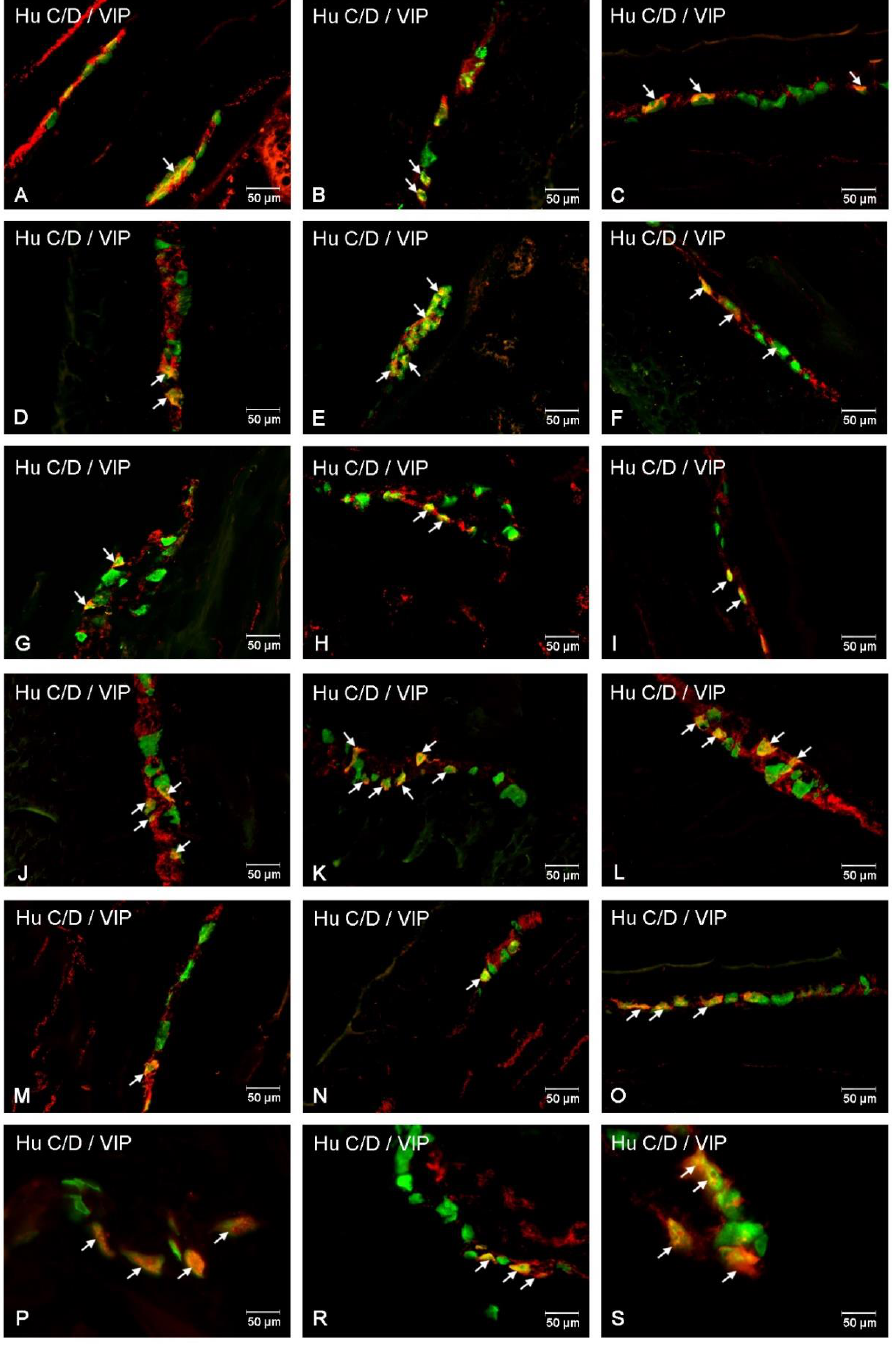
Figure 6. Immunofluorescent staining presenting VIP immunoreactivity in cell bodies in the particular intramural plexuses in the small intestine in both control and experimental groups. All photographs have been created by the digital superimposition of two color channels; Hu C / D-positive—used here as a pan-neuronal marker (green), and VIP-positive (red). The arrow shows perikaryon containing both examined substances. Myenteric plexus of the duodenum ( A,D ), jejunum ( B,E ), and ileum ( C,F ) under physiological condition ( A–C ) and after streptozotocin administration ( D–F ). Outer submucosal plexus of the duodenum ( G,J ), jejunum ( H,K ), and ileum ( I,L ) under physiological condition ( G–I ) and after streptozotocin administration ( J–L ). Inner submucosal plexus of the duodenum ( M,P ), jejunum ( N,R ), and ileum ( O,S ) under physiological condition ( M–O ) and after streptozotocin administration ( P–S